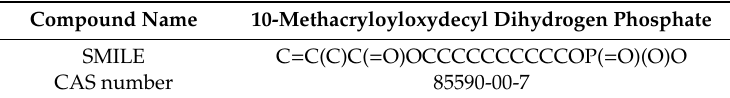
Figure 1. Confirmation of terminal double bond groups for polymerization of MDP (10- Methacryloyloxidecyl Dihydrogen Phosphate) by 1 H NMR spectrum. ( a ) Polymerizable group; ( b ) hydrophobic group; ( c ) polymerizable and hydrophobic groups with acetone peak. Table 1. The SMILE (Simplified Molecular-Input Line-Entry system) of organic compound with associated CAS (Chemical Abstracts Service) number.